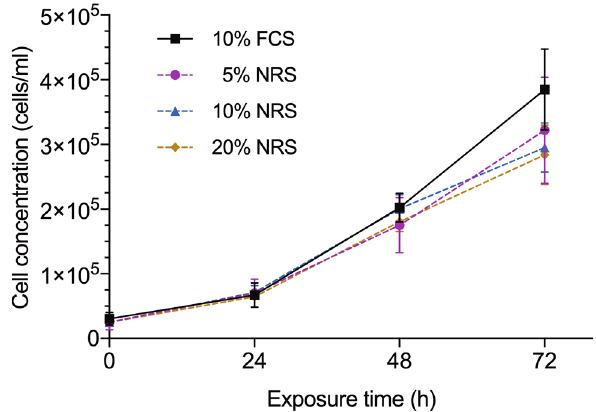
Figure 1. Proliferation curve of CC531 cell cultures. Cell concentration after 24, 48 and 72 h of exposure to different experimental conditions. Control (10% FCS) and normal rat serum (5%, 10%, 20%). Figure and analysis were performed using GraphPad Prism version 6.04 for Windows, GraphPad Software, San Diego, California USA, www.graph pad.com.